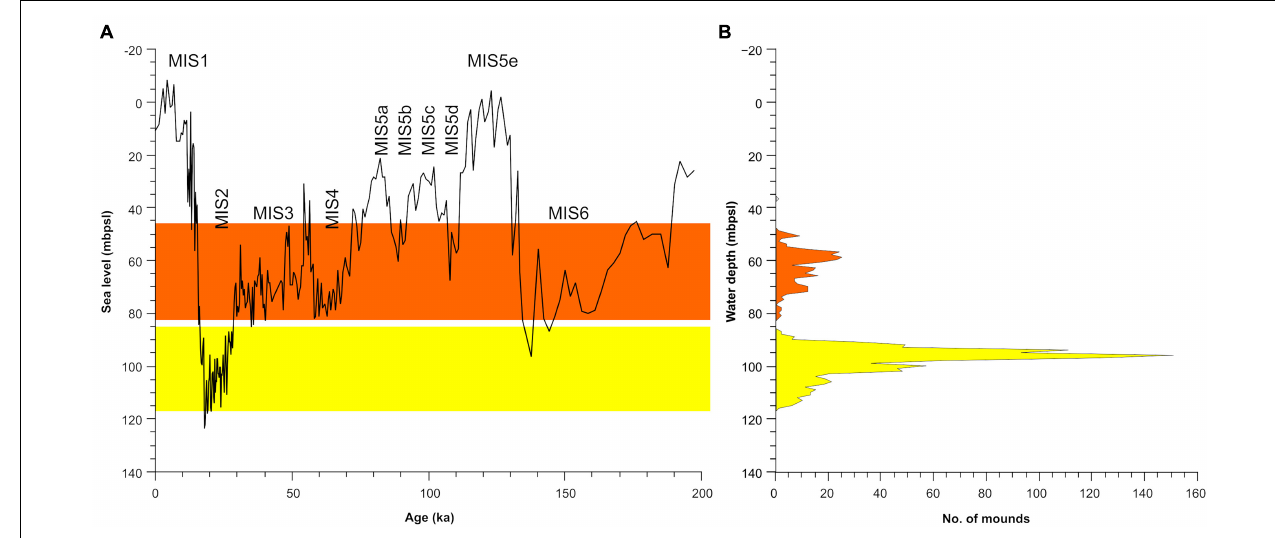
FIGURE 9 | (A) Sea-level curve of the last glacial cycle (left, Miller et al., 2020) and (B) water depth ranges of the mounds. Note that most of the mounds relate to water depths associated with low stands. Gray gradient illustrates relative density of mounds in a given depth.